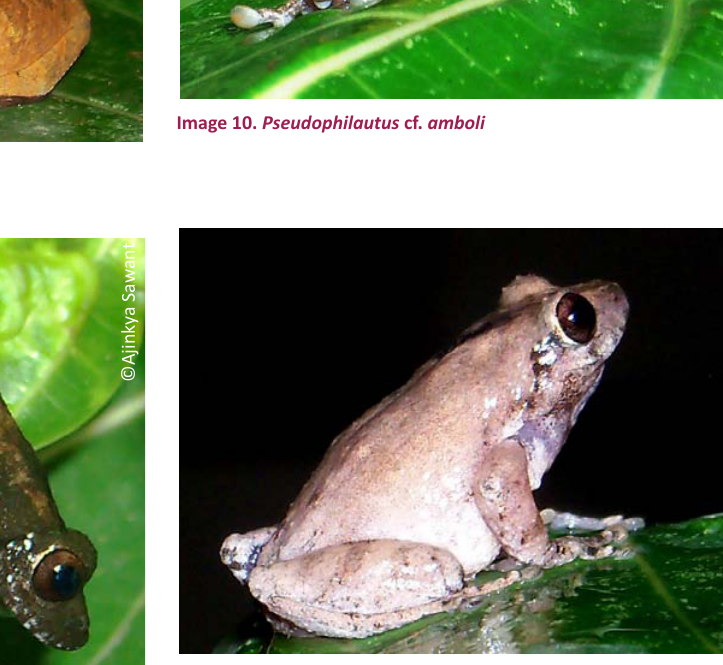
Image 12. Raorchestes cf.